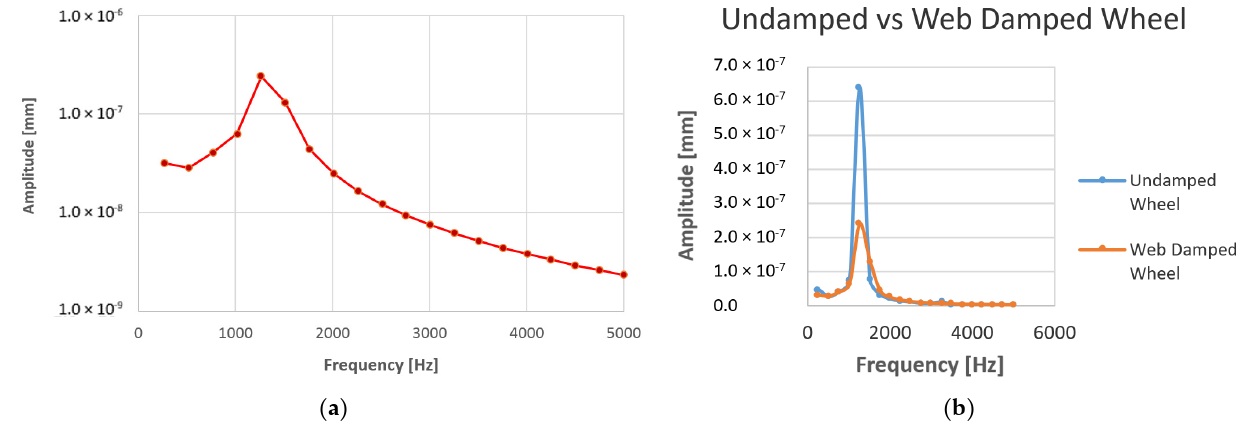
Figure 14. Harmonic response analysis in the radial direction with viscoelastic damping layer on the web of both sides of the wheel. ( a ) Radial excitation of the wheel mounted with viscoelastic layer on the web. ( b ) Comparison between the undamped and web damped wheels when radially excited.